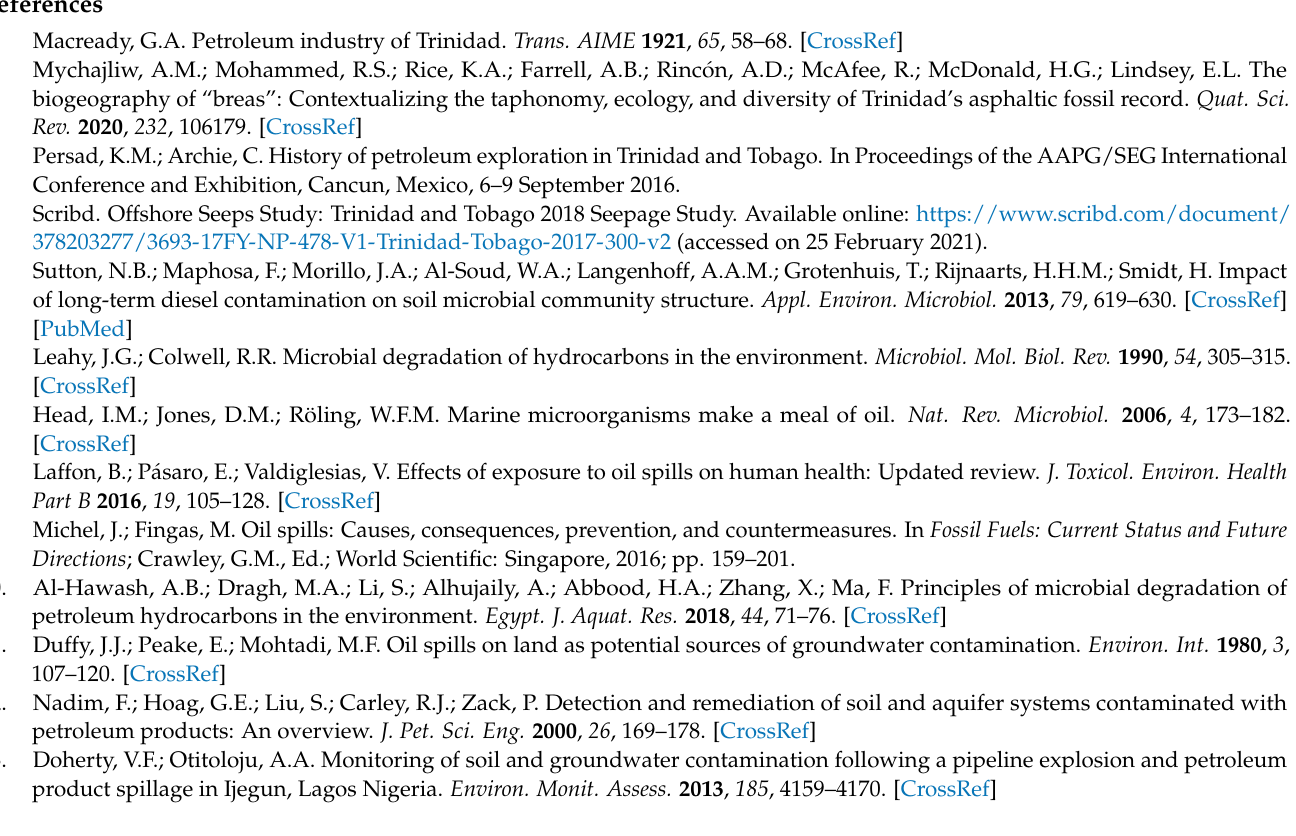
Table S10: Diversity indices for yeast communities in the 8 sites in southwestern Trinidad. Table S11: SIMPER analysis. Cumulative and overall contributions of key contributing genera responsible for the observed patterns between sites. For example, for the filamentous fungal community, differences between Pablito and Fyzabad are driven by Aspergillus , Epicoccum , Roussoella , Eutypella , Sydowia , Trichoderma , Oudemansiella , and Paraconiothyrium in descending order; together, these eight genera drive more than 70% of the difference between the communities in Pablito and Fyzabad; overall, the fungal communities in Pablito and Fyzabad are 91.7% different from each